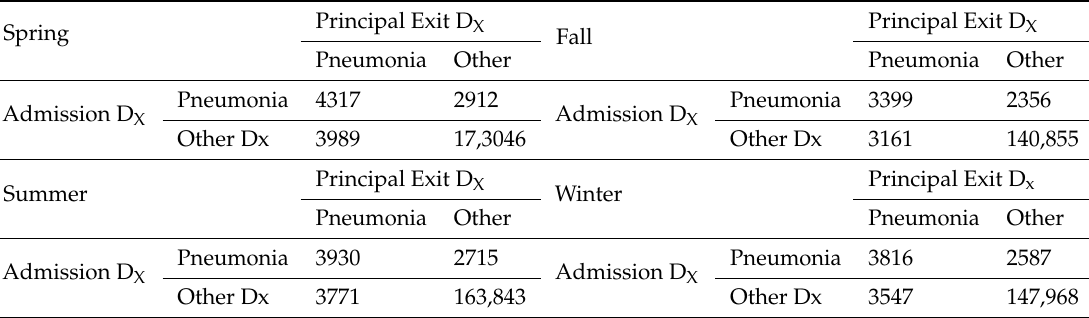
Table 3. Confusion matrices for the admission → discharge discrepancies of pneumonia.